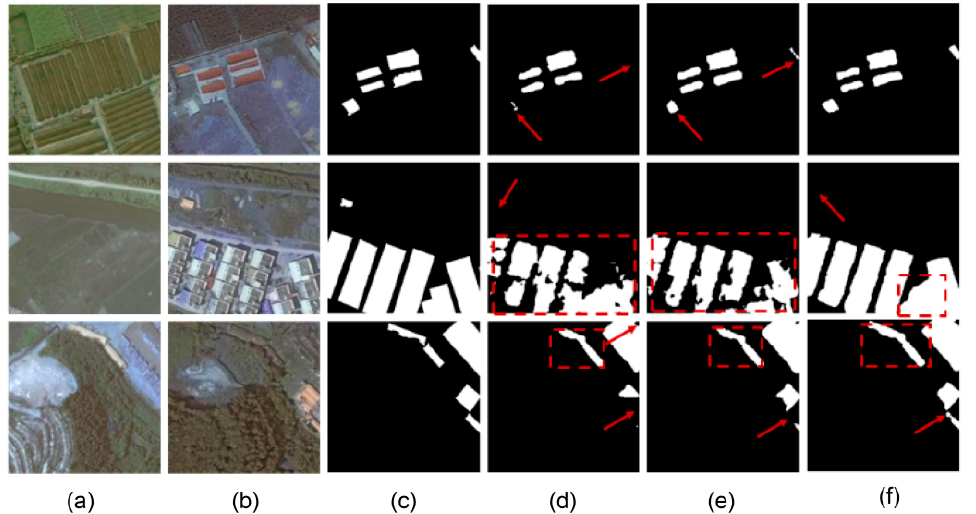
Figure 7. Comparison example of model experiment results on the Google dataset. ( a ) Image T1, ( b ) Image T2, ( c ) truth map of change detection, ( d ) the result of FC-Siam-diff, ( e ) the result of Unet++, and ( f ) the result of this paper. The red rectangular boxes and red arrows mark the differences between the variogram (CM) and the true value graph (GT) given by the model.